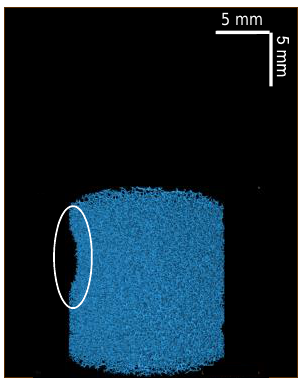
Figure 8. Three-dimensional µCT reconstructed image of one of the two 60% compressed plugs related to the outlier points in Figure 7. An indentation, caused by a bending of the plug when compressed, is highlighted by a white circle.